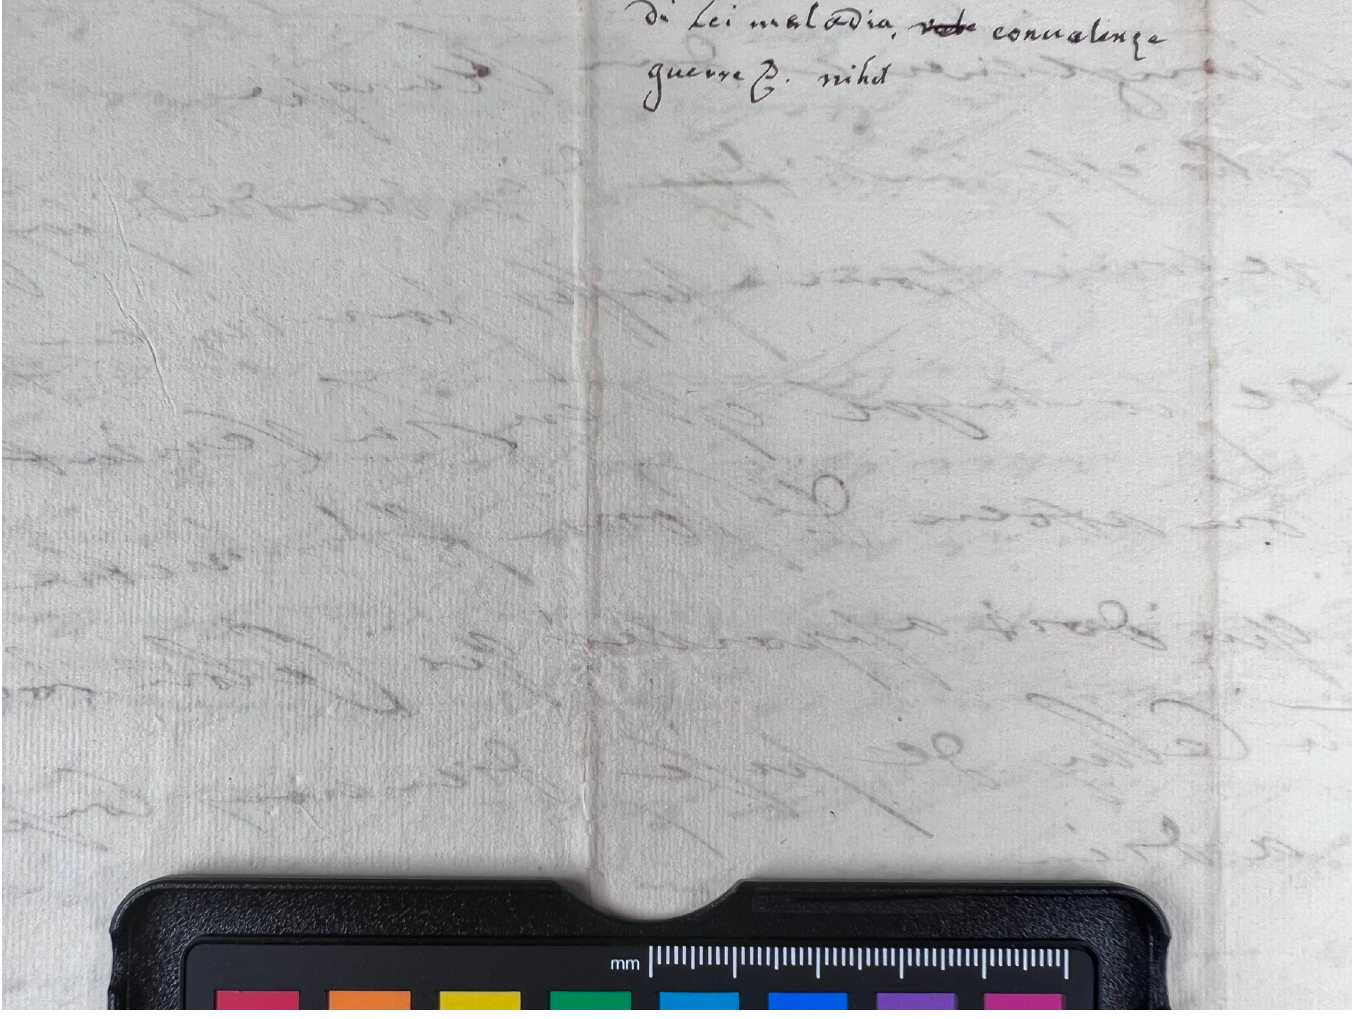
PLOS ONE | https://doi.org/10.1371/journal.pone.0283539 April 12,